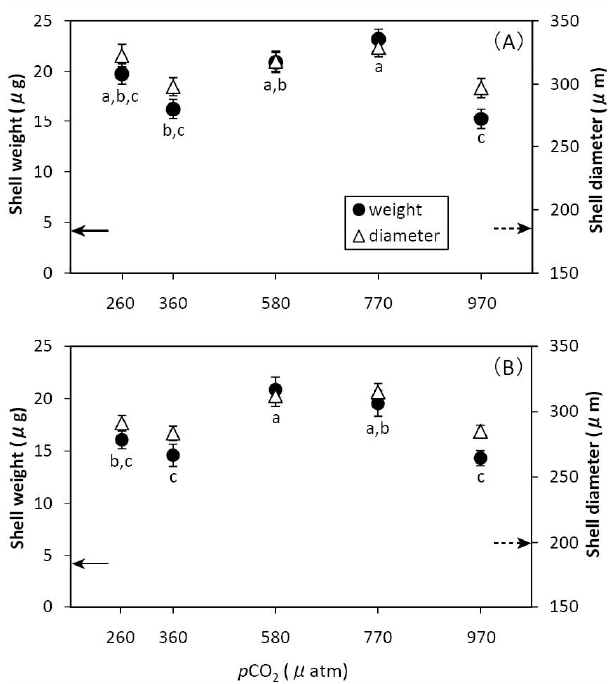
Fig. 4. Mean shell diameter and weight of Calcarina gaudichaudii after culture for about 12 weeks at five p CO 2 levels. Values are means ± SE of the 20 clone individuals sampled in each treatment. Different letters above plotted treatment values indicate a signifi- cant difference ( α = 0.05) in shell weight according to Tukey’s HSD post hoc test. Dashed and solid arrows show mean shell diameter and weight of clone individuals, respectively, at the start of the ex- periment. (A) Population α , (B) population β